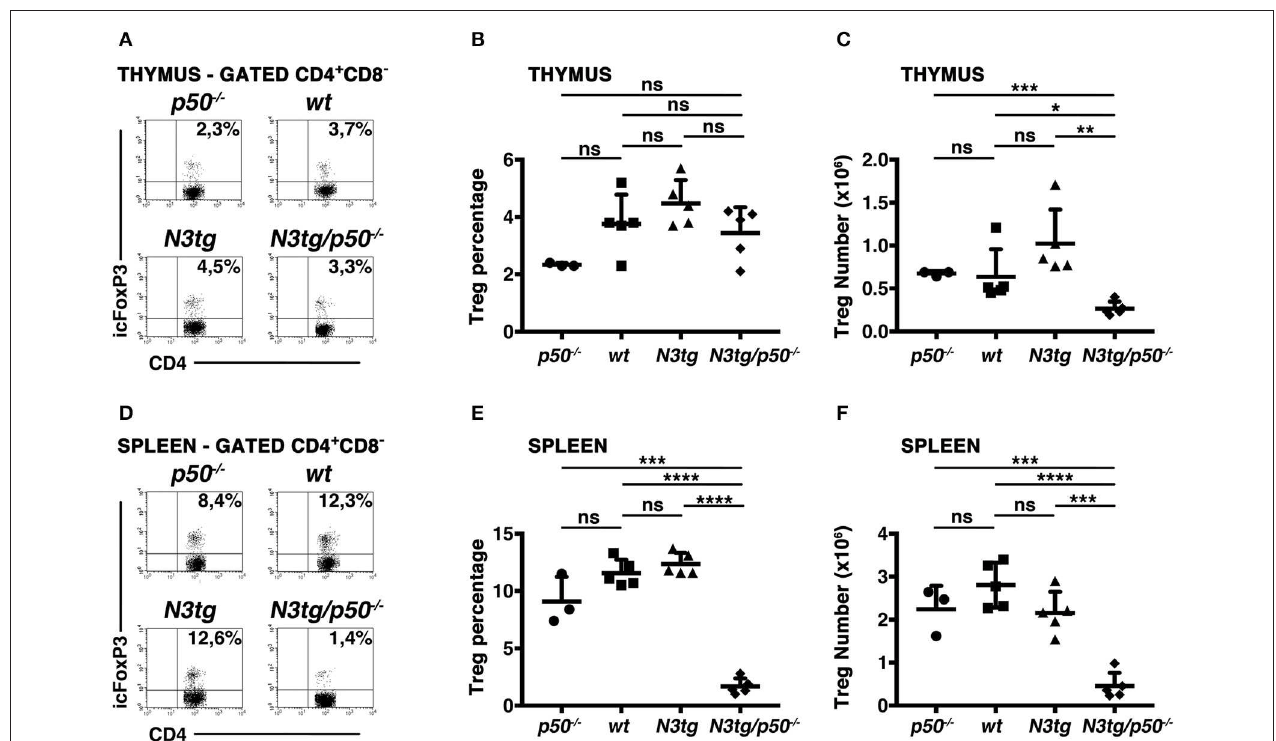
FIGURE 8 | Tregs are reduced in the thymus and spleen of N3tg/p50 − / − double-mutant mice. (A) and (D) Representative FACS analysis of CD4 + CD8 − Foxp3 + Tregs in the thymus and spleen, respectively, of N3tg/p50 − / − , N3tg , p50 − / − and wt mice at 4–5 weeks of age. Numbers inside each cytogram represent the percentages of Foxp3 + cells inside gated CD4 + CD8 − cells. (B) and (C) Mean percentage values and absolute numbers, respectively, of CD4 + CD8 − Foxp3 + Tregs in the thymus from N3tg/p50 − / − , N3tg , p50 − / − , and wt mice, assessed as in (A) . (E,F) Percentages and absolute numbers, respectively, of CD4 + CD8 − Foxp3 + Tregs in the spleen from N3tg/p50 − / − , N3tg , p50 − / − , and wt mice, assessed as in (D) . In (B,C,E,F) the values are presented as mean ± SD of three independent experiments with N3tg/p50 − / − ( n = 5), N3tg ( n = 5), p50 − / − ( n = 3), and wt ( n = 5) mice. ns, not significant; * P ≤ 0.05, ** P ≤ 0.01, *** P ≤ 0.001, and **** P ≤ 0.0001 represent significant differences between the indicated